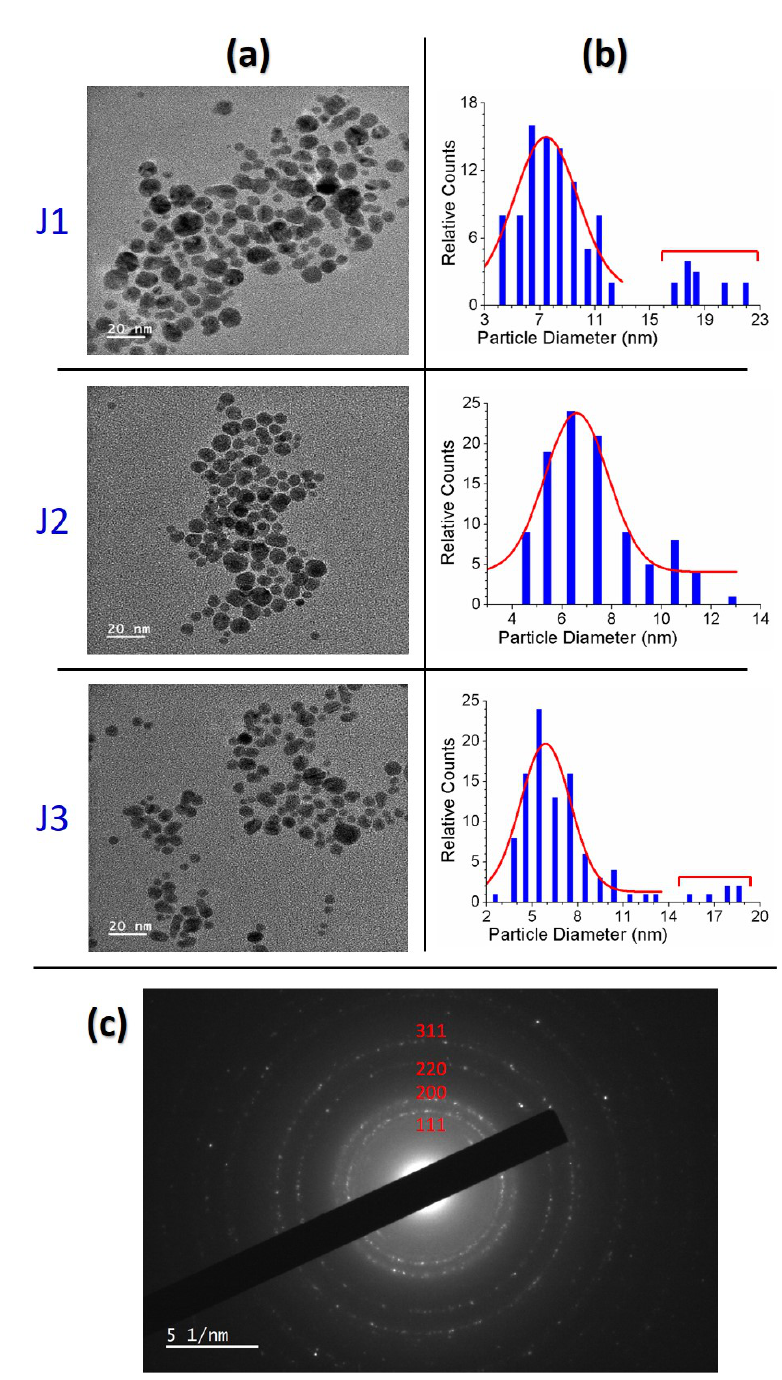
Figure 9. ( a ) HR-TEM images and ( b ) particle size distributions of the Ag@Cit NPs synthesized by treating AgNO 3 -TSC-DW for 10 min with the J1, J2, and J3 jets. ( c ) Electron diffraction patterns of the Ag@Cit NPs synthesized with the J2